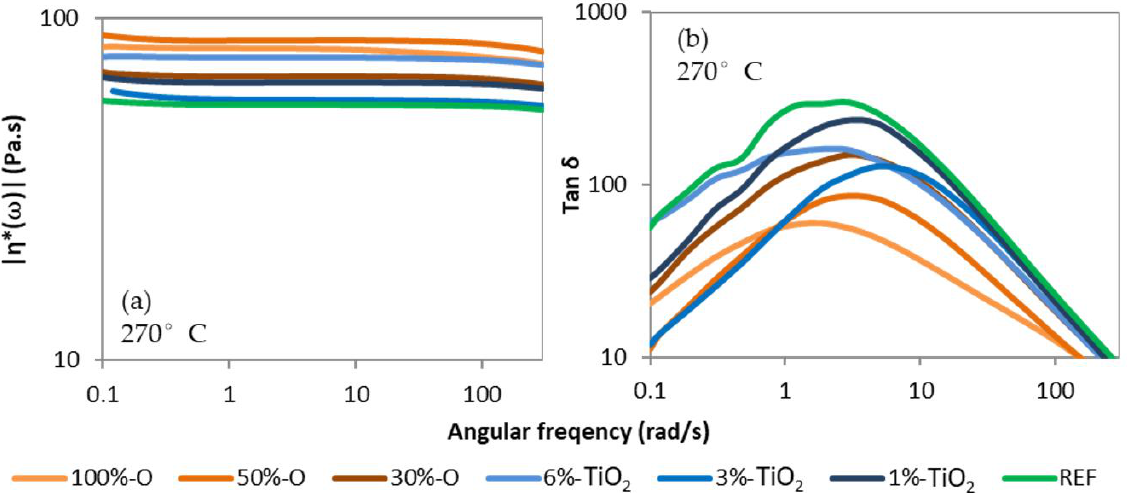
Figure 3. ( a ) Absolute complex shear viscosity, and ( b ) tan δ, of extruded blends. Measurements realized at 270 °C. realized at 270 ◦